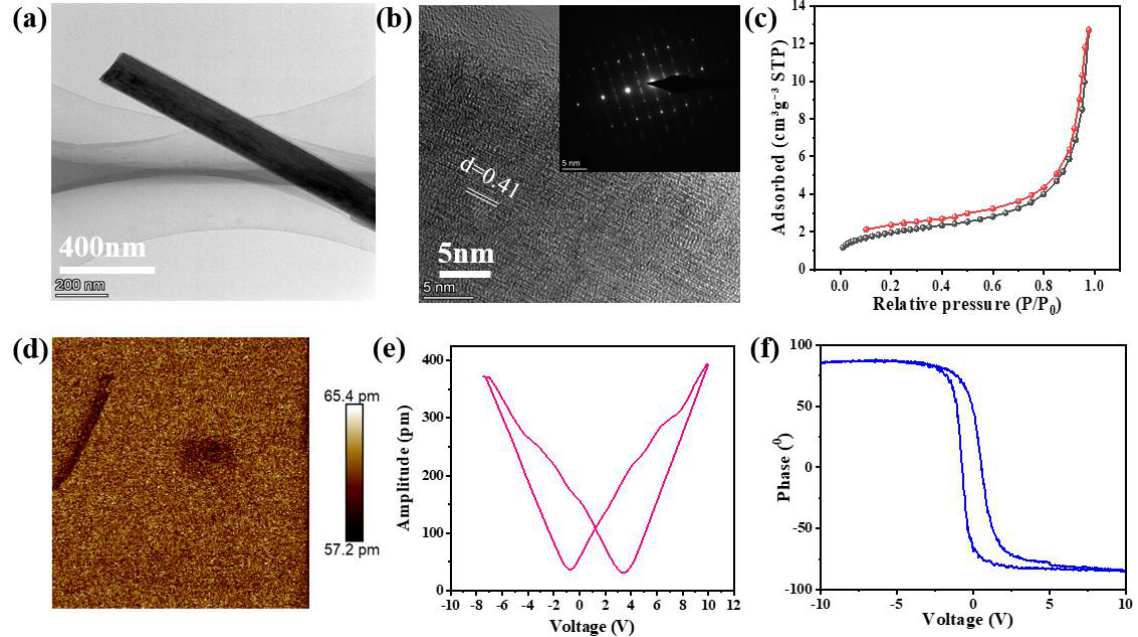
Figure 2. ( a , b ) TEM images and the corresponding SEAD pattern of BTO-180. ( c ) The N 2 adsorption curve of BTO-180. ( d ) PFM images of BTO-180. ( e , f ) The butterfly curves and a reverse piezoelectric hysteresis loop of BTO-180.